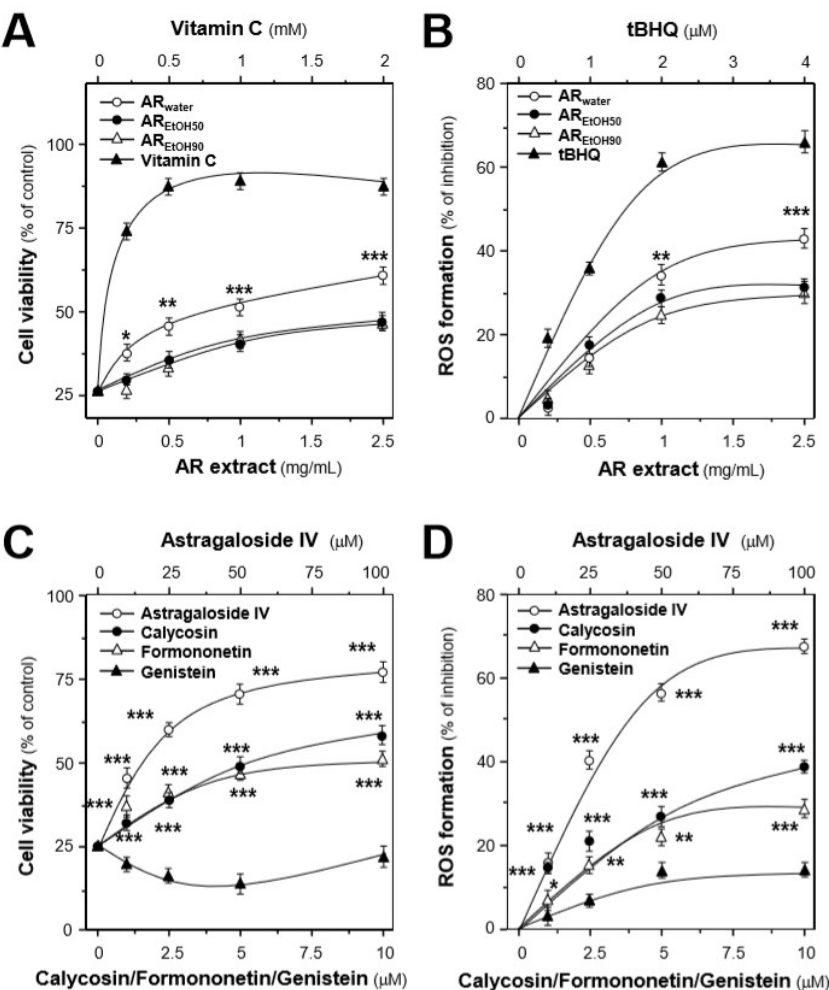
Figure 3. Protection effects of the AR extracts and major compounds in H9C2 cells against oxidative stress. ( A ) The dose-dependent response was determined by pre-treating the cultures with AR extracts (batch AR-1), i.e., water extract of AR (AR water ), 50% ethanol extract of AR (AR EtOH50 ), and 90% ethanol extract of AR (AR EtOH90 ) for 24 h before the addition of tBHP (150 µ M). Vitamin C at various concentrations served as a positive control. ( B ) Cultured H9C2 cells were pre-treated with the AR extracts or tert -butyl hydroquinone (tBHQ) for 24 h and then exposed to tBHP (150 µ M) for 1 h. The result is in percentage of ROS formation relative to the tBHP-treated control. ( C ) Cultured H9C2 cells were treated with the AR major compounds for 24 h before the addition of tBHP (150 µ M). Then, the cell viability was recorded. ( D ) The effects of the chosen markers on ROS formation were compared in tBHP-treated cardiomyocytes. All data are expressed as mean ± SD, n = 5, each with triplicate samples. Statistical comparison was made with the sample with the lowest value of the corresponding concentration, * p < 0.05, ** p < 0.01, *** p < 0.001.